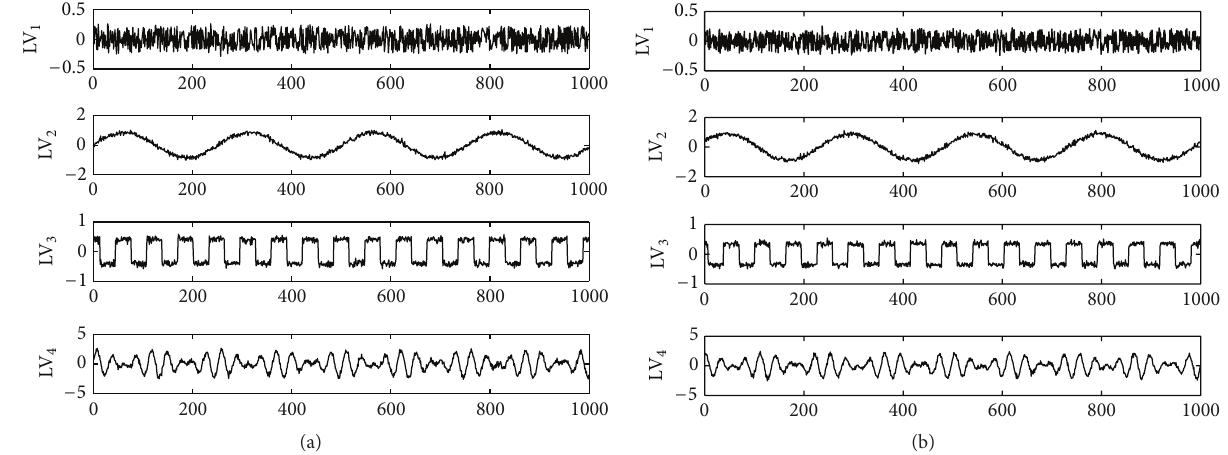
Figure 4: (a) The LVs estimated in X using CCA. (b) The LVs estimated in Y using CCA.